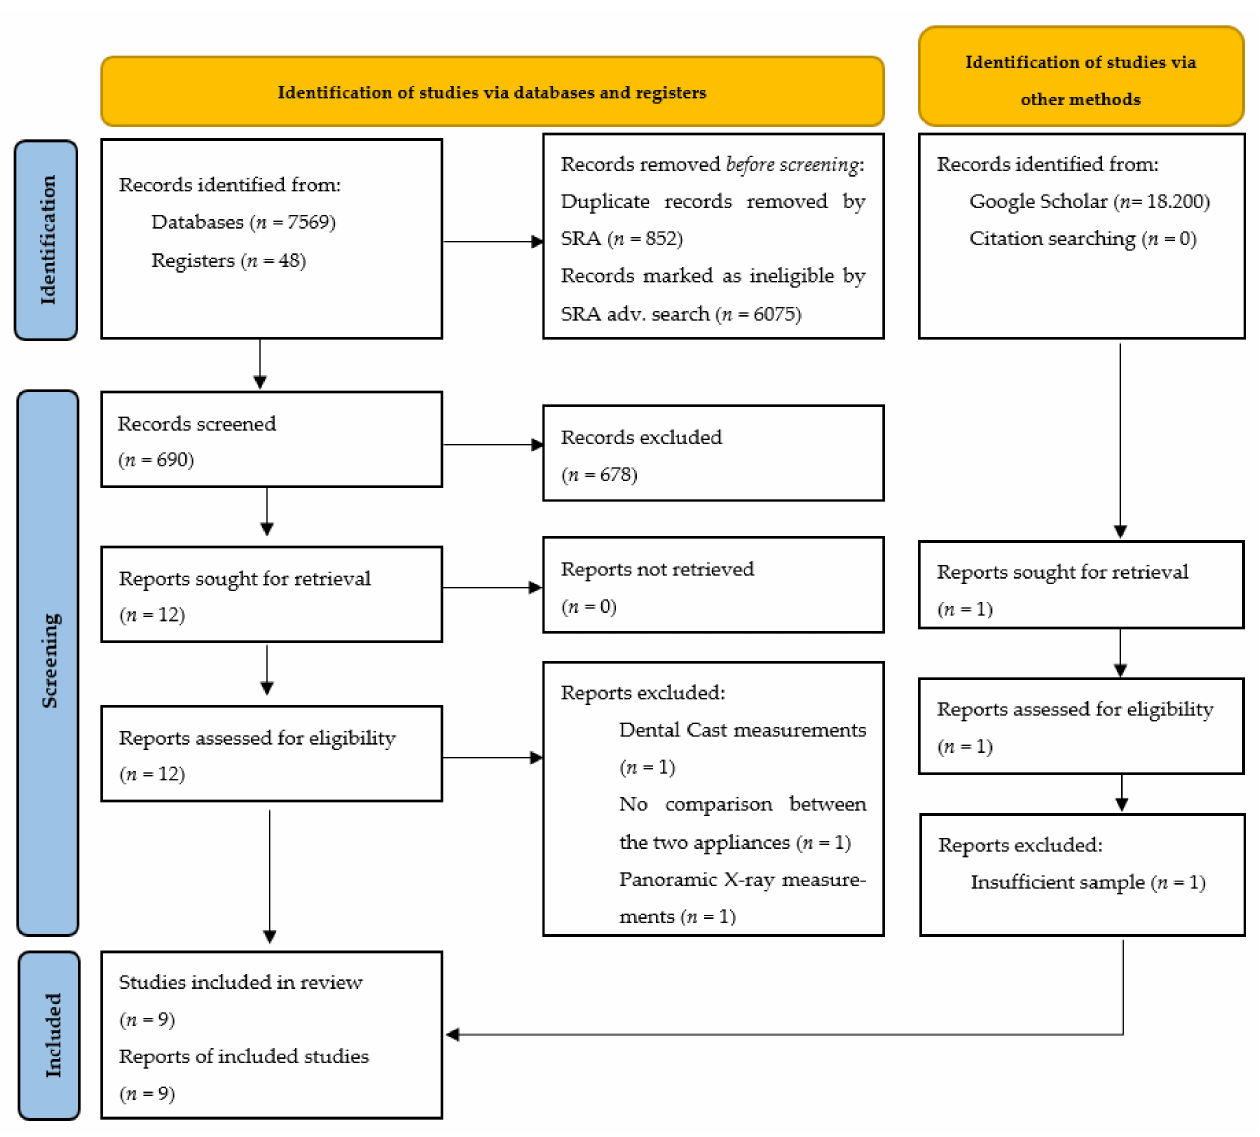
Figure 1. PRISMA 2020 flow diagram for new systematic reviews which included searches of databases, registers, and other sources